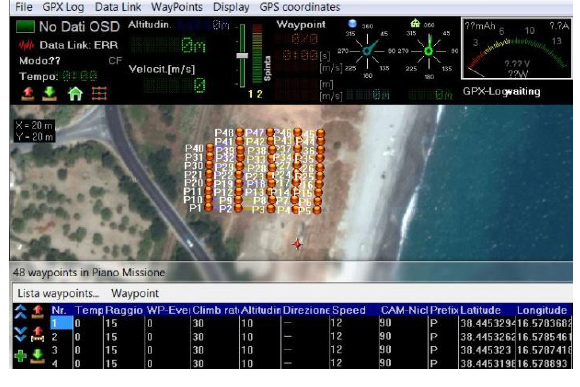
Figure 3. Flight